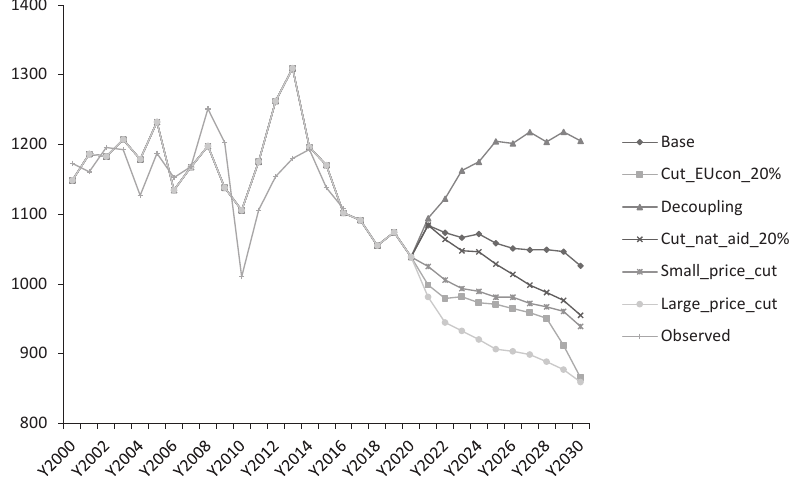
Fig. 7. Simulated cereals production area 2000–2029 in different scenarios vs observed cereals production areas for 2000–2016 in